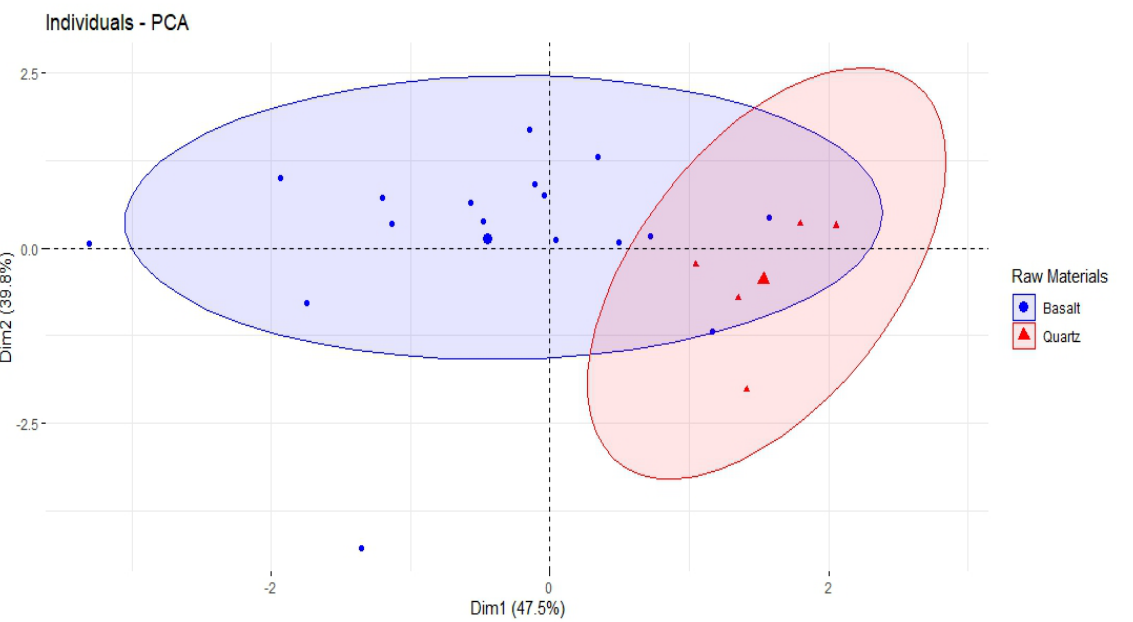
Figure 10. Principal Components Analysis results for cores exploitation dynamics, using 95% data capture ellipses and coloured by raw material.